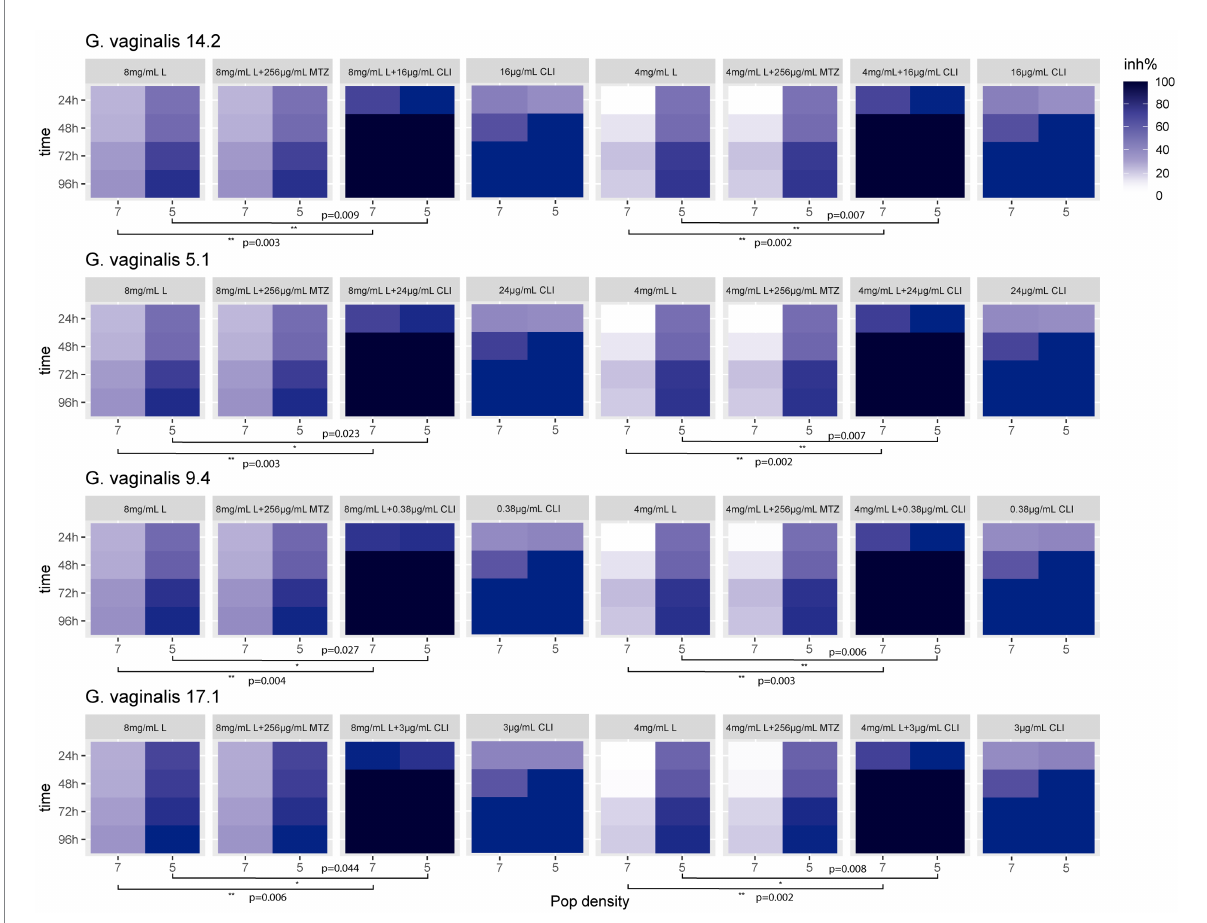
FIGURE 3 Heat map of the inhibition rate percentage (inh%) exhibited by the presumptive G. vaginalis 14.2, 5.1, 9.4, and 17.1 clinical isolates, tested at both 7 and 5 log units, in the presence of bovine lactoferrin (MTbLF; 8 or 4 mg/ml) and antibiotic (metronidazole or clindamycin). Stars indicate statistically significant differences based on two-tailed Student’s t